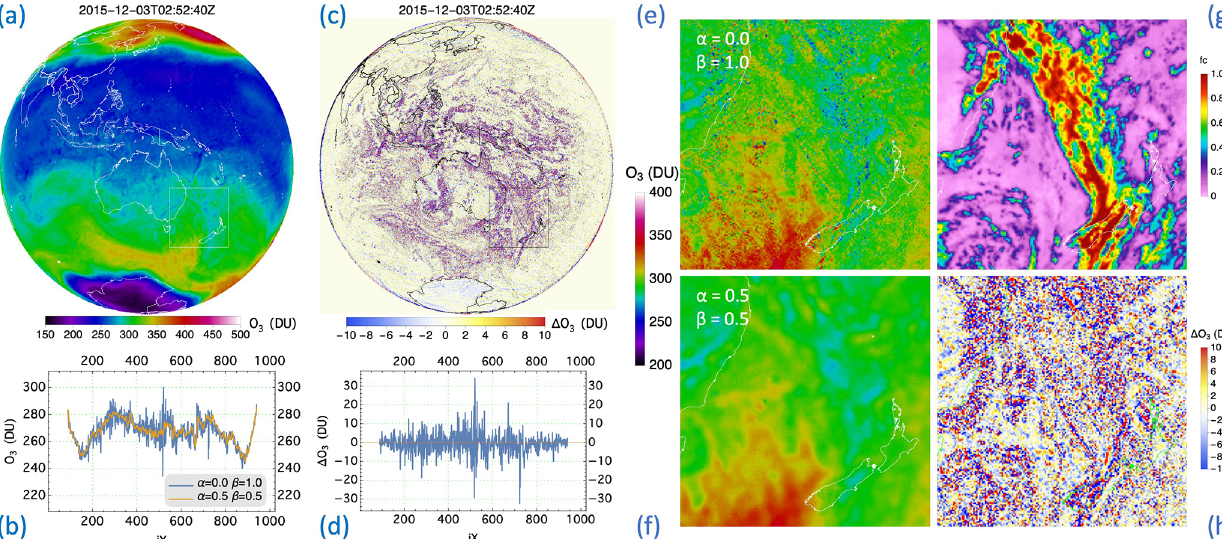
Figure 14. Retrieved O 3 from EPIC measurements of bands B1, B3, and B4 on 3 December 2015. (a) Optimized (i.e., α = 0 . 5 , β = 0 . 5) O 3 map based on the SOE method; (b) a comparison of optimized (orange) and independent-pixel (blue, α = 0 , β = 1) O 3 along the horizontal line (left to right) across the middle of the O 3 map in (a) ; (c) the O 3 difference map: (cid:49) O 3 = O 3 ( optimized ) − O 3 ( independent pixel ) ; (d) the O 3 difference along the horizontal line across the middle of the map in (c) ; (e) a zoom-in of the independent-pixel O 3 map; (f) the optimized O 3 corresponding to the rectangle in (a) ; (g) cloud fraction f c corresponding to (e) and (f) ; (h) O 3 difference (optimized − independent pixel), with a zoom-in corresponding to the rectangle in (c)